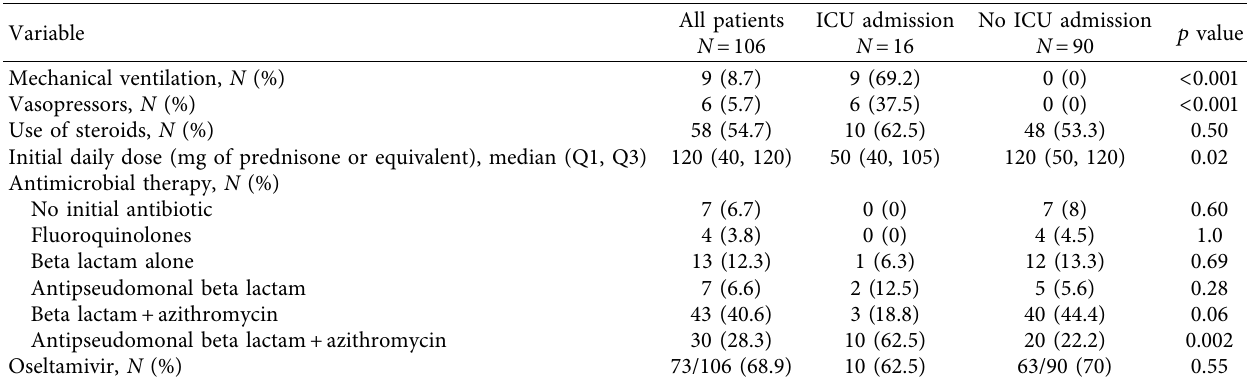
Table 2: Management of patients.